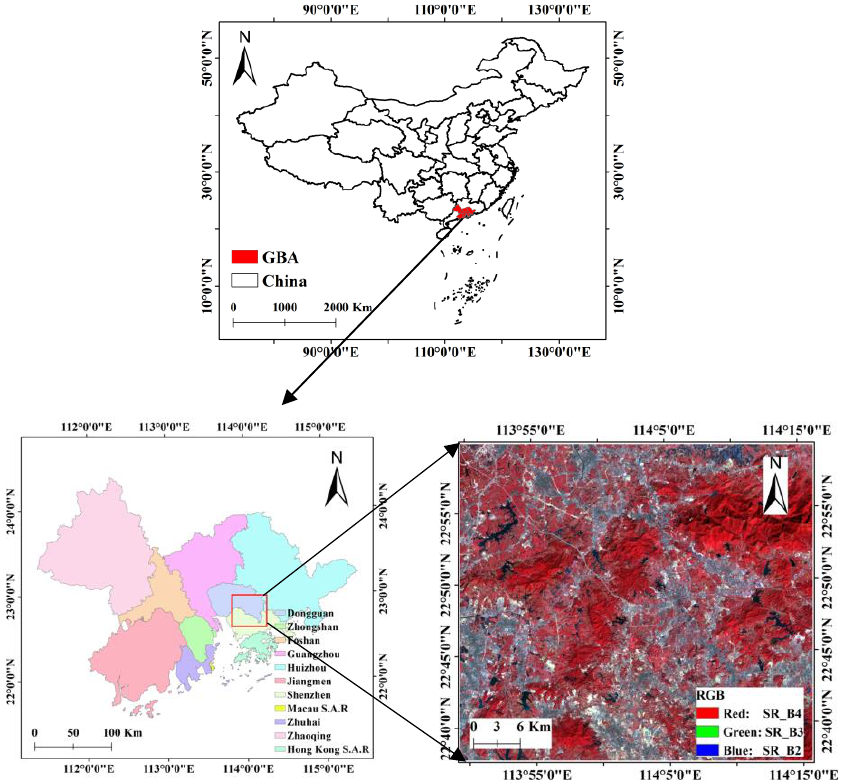
Figure 1. The study area is located in Shenzhen and Dongguan within the GBA of China.